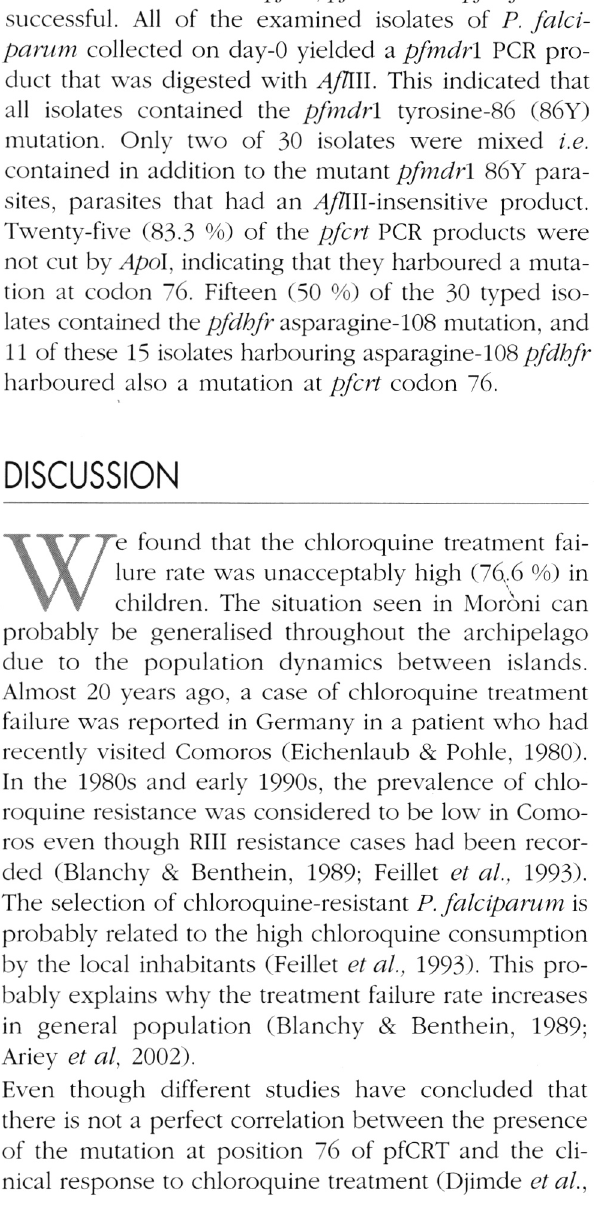
Table I. - Outcome of chloroquine treatment in Comorian children and prevalence of Plasmodium falciparum with mutation at codon 76 in pfcrt (samples were collected on Day